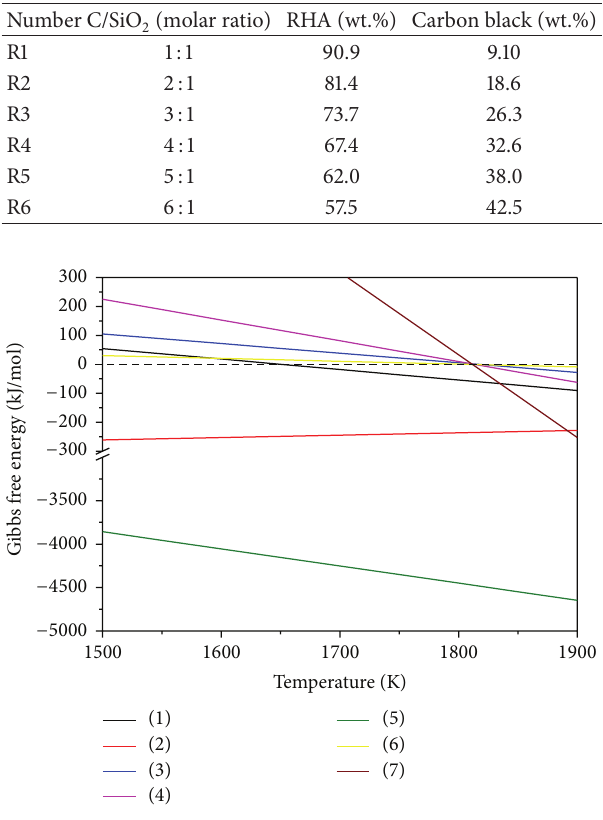
Figure 1: The changes of Gibbs free energy of reactions (1)–(7) as the